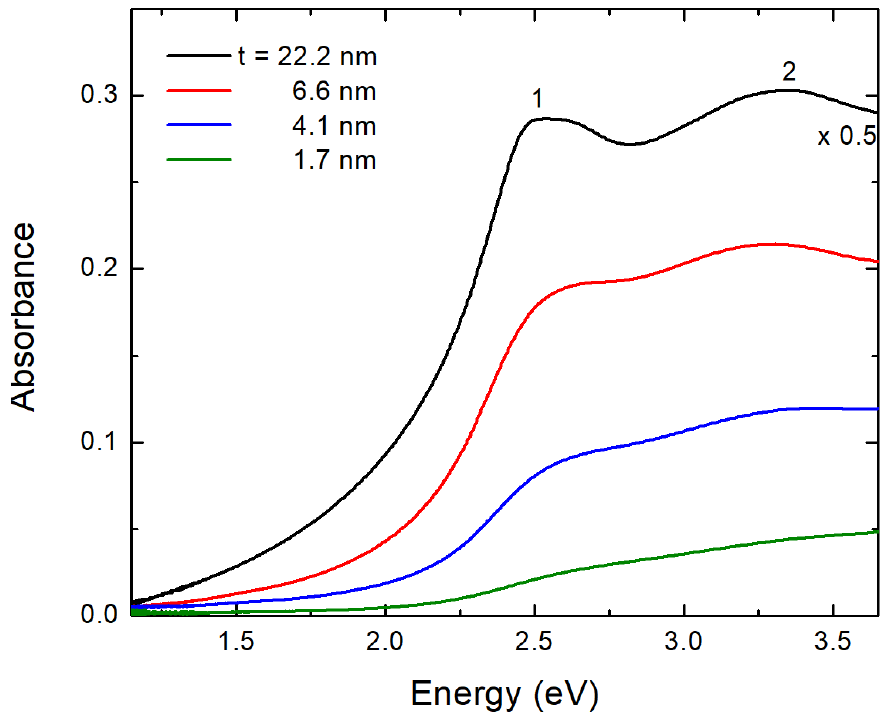
Figure 2. Absorbance spectra for four PdO films; their thickness t is indicated. The absorbance of the thickest film is multiplied by 0.5 for better presentation of the